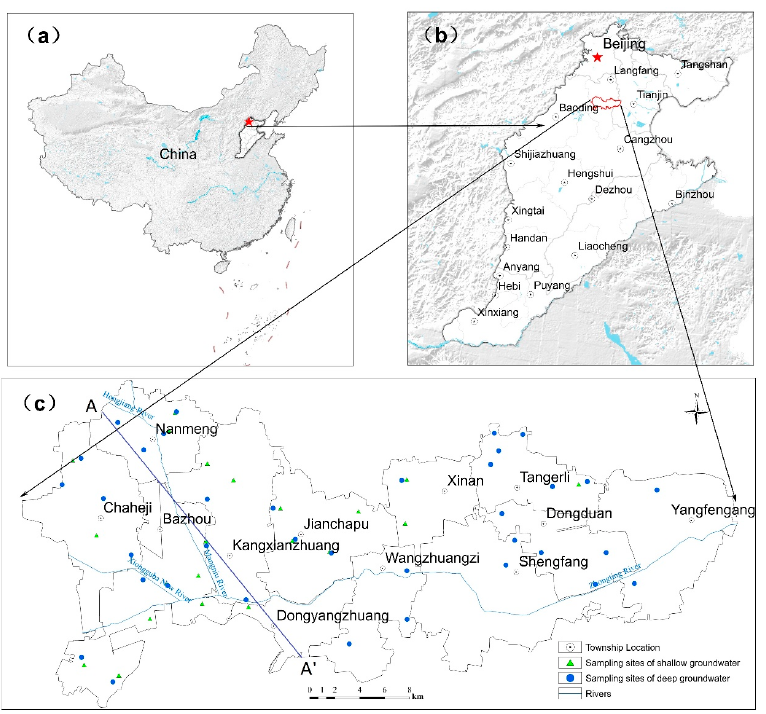
Figure 1. Location of the study area and the sampling sites (( a ) China, ( b ) the North China Plain, ( c ) the study area and the sampling sites). The study area possesses typicality in the aspect of hydrogeological conditions and groundwater utilization for the research of groundwater quality, function or suitability. Field investigation shows that groundwater in this region is mainly deposited in the loose sand layer pore of the Quaternary system. The aquifer exhibits spatial gradient character- istics, changing from a single structure composed of freshwater to a multilayer structure composed of freshwater and saltwater from northwest to southeast. The flow direction of both shallow and deep groundwater is generally from northwest to southeast, and the groundwater flow field is changed in the local groundwater funnel area under the influ- ence of over-exploitation. Groundwater in the study region can be divided into shallow groundwater and deep groundwater according to the regional hydrogeological conditions and groundwater ex- ploitation. The depths of shallow groundwater wells are 20–150 m below the surface, while the depths of deep groundwater wells are 150–650 m. In general, the groundwater level is greatly affected by exploitation and precipitation. The shallow groundwater levels are 2–30 m below the surface, while the deep groundwater levels are within the depths of 30–90 m. The aquifer system can be classified into four different aquifers by its lithological properties and geological age, named I, II, III and IV from top to bottom vertically [48] (Figure 2). Aquifer I is unconfined, composed of sand gravel, medium sand, fine sand and silty-fine sand, and the depths of the aquifer bottom are 30–50 m. Aquifer II, 140–160 m deep, is a semi-confined aquifer. Aquifer III consists of sandy gravel and medium to fine